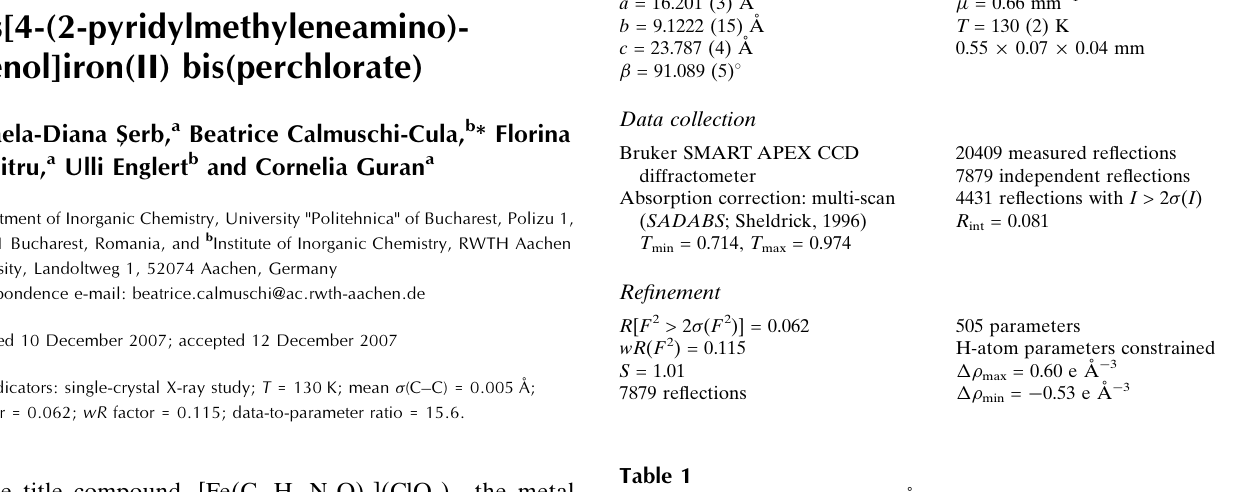
Selected geometric parameters (A˚ , (cid:2) ).